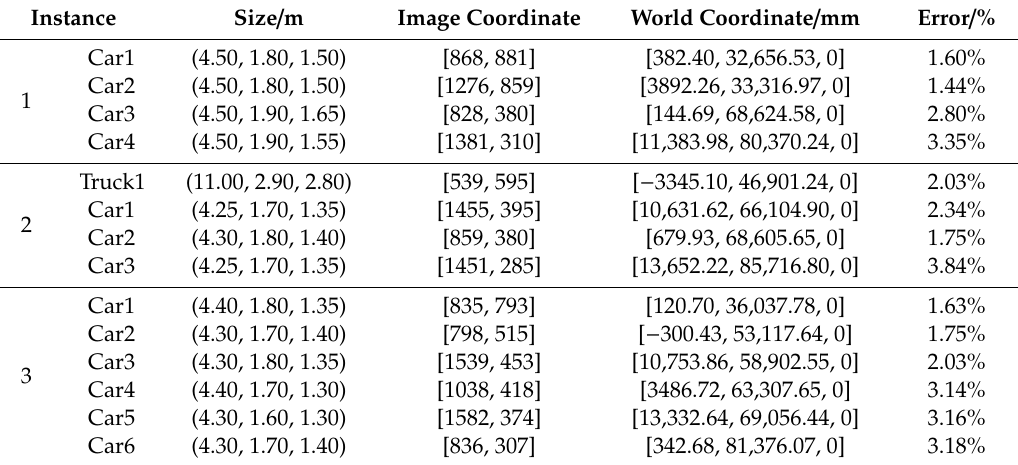
Table 4. Measurement of vehicle spatial distribution errors in dataset scene 2.